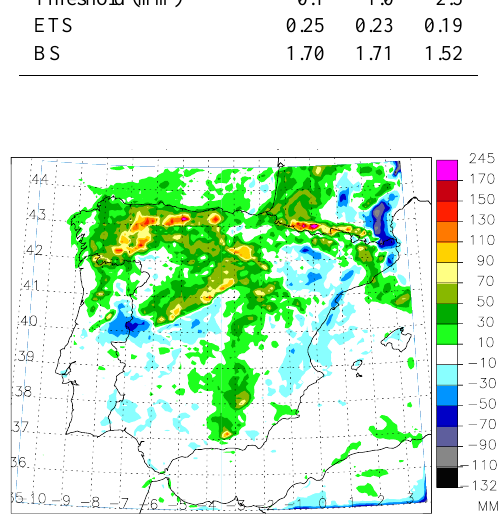
Fig. 4. Accumulated precipitation difference, in mm, from 30 May Fig. 4 Accumulated precipitation difference, in mm, from 30 May to 20 June 2002. to 20 June